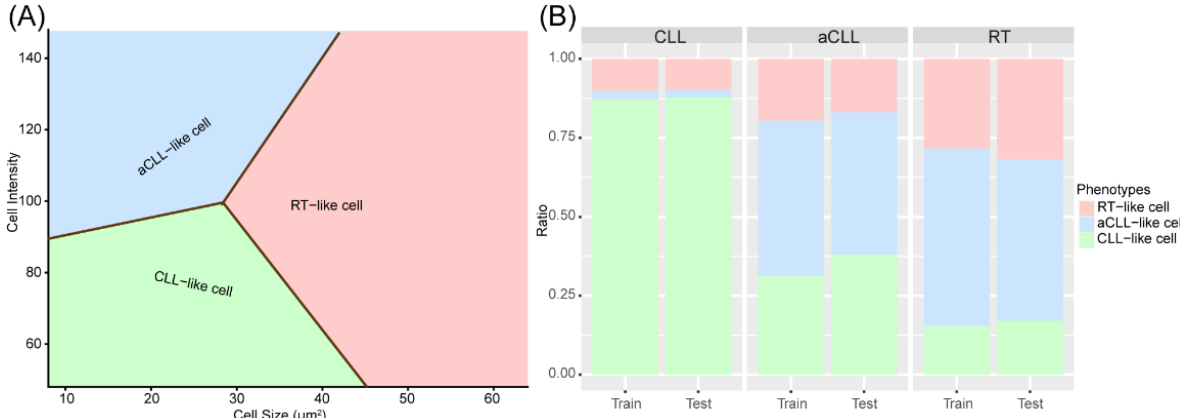
Figure 4. The trained multiple class logistic regression (LR) for labeling CLL-like, aCLL-like, and RT-like cells: ( A ) The decision boundaries of the three cell phenotypes (CLL-like, aCLL-like, and RT-like cells). ( B ) The ratios of the three cell phenotypes in CLL, aCLL, and RT in the training and testing cohorts show consistency.